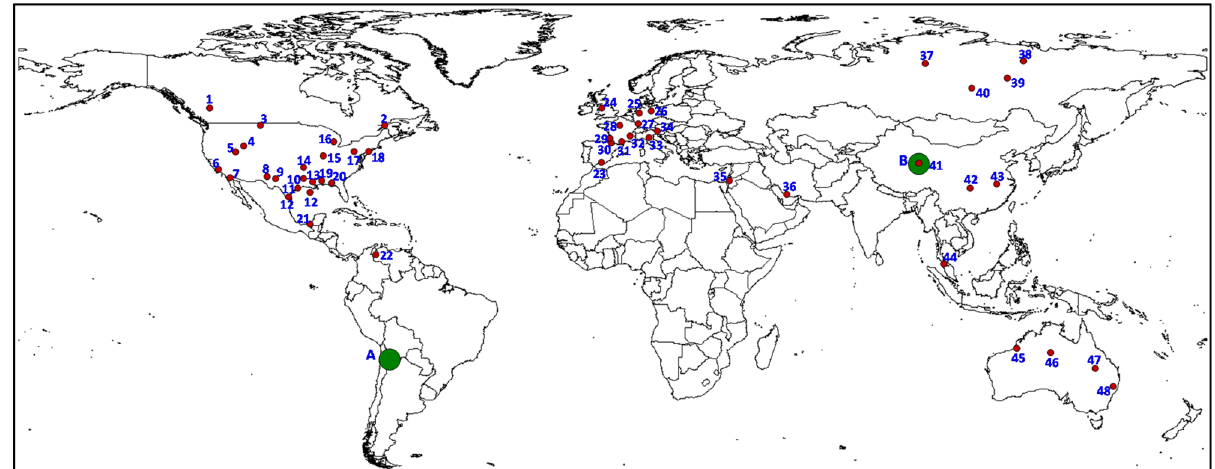
Figure 1. World map showing the sedimentary basins, salars and salt lakes with published data used in this study. Red dots: sedimentary formation waters; green circles: closed basin brines (salars and salt lakes). The numbers and capital letters in blue refer to the identification number in Table